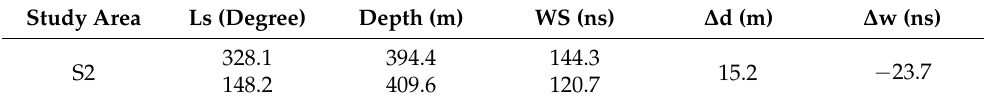
Table 1. The thickness measurement in S1. Ls: solar longitude; WS: FWHM of radar echo on the surface; Depth: the depth of the lower interface of AA 3c ; ∆ d: the thickness difference of AA 3c in the two different seasons; ∆ w: the pulse-width difference of surface echo in the two different seasons. The data points correspond to Figure 7a–d, track numbers are 0564201 and 3577202. Study Area Ls (Degree) Depth (m) WS (ns) ∆ d (m) ∆ w (ns) 309.4 348.8 138.6 S1 30.4 − 23.3 92.0 379.2 115.3 Table 2. The thickness measurement in S2. Ls: solar longitude; WS: FWHM of radar echo on the surface, Depth: the depth of the lower interface of AA 3c , ∆ d: the thickness difference of AA 3c in the two different seasons; ∆ w: the pulse-width difference of surface echo in the two different seasons. The data points correspond to Figure 7e–h; track numbers are 0564201 and 1056001. Study Area Ls (Degree) Depth (m) WS (ns) ∆ d (m) ∆ w (ns) 328.1 S2